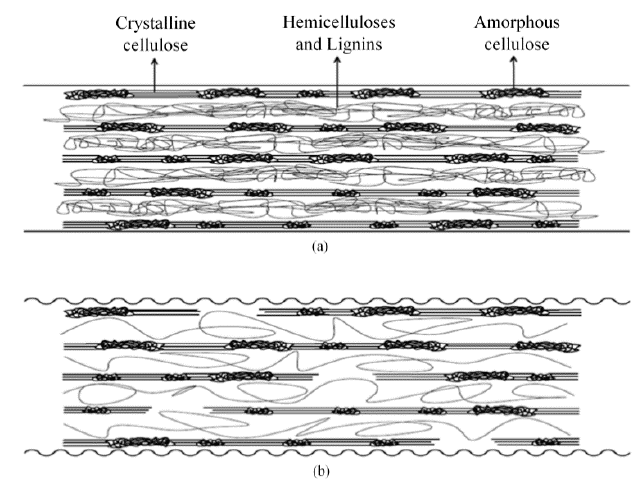
Figure 6. Schematic illustration showing the hypothetical effect of alkali treatment on the sisal fiber structure: ( a ) untreated fiber; and ( b ) alkali treated fiber.